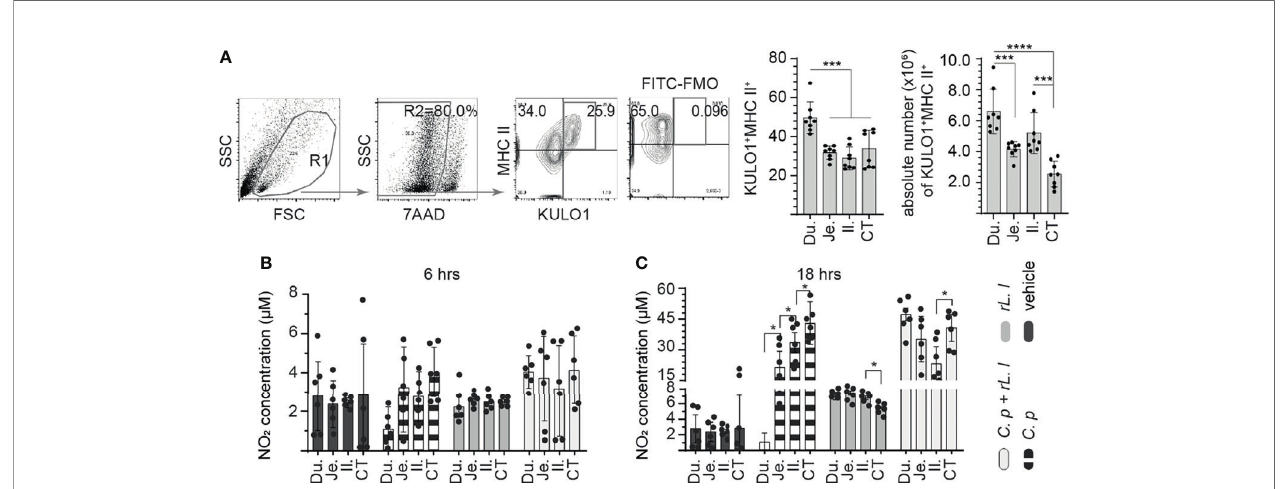
FIGURE 1 | Ex vivo induction of NO production by C perfringens treatment of intestinal monocyte/macrophages. The frequency of small intestine mononuclear cells isolated from 3-week-old layer chickens ( n = 8) were analyzed using fl ow cytometry. (A) Dot plots demonstrating the gating strategy utilized to de fi ne the frequency and absolute numbers of monocyte/macrophages (KULO1+MHC II+) within the duodenum, jejunum, ileum, and cecal tonsils. The respective small intestine mononuclear cells were stimulated with medium alone (vehicle), LPS (1 m g/ml), C perfringens (1 MOI), L. lactis (MOI = 1), and combination of C perfringens (MOI = 1) and L. lactis (MOI = 1). Supernatants were collected at (B) 6 and (C) 18 h poststimulation and NO concentration were quanti fi ed. Paired t -test was used to assess normal distribution and test signi fi cance. * p < 0.05, *** p < 0.0005 and **** p < 0.0001 indicates a statistically signi fi cant difference. The mean ± SD value are shown from three independent experiments performed in triplicates. Du, duodenum; Je, jejunum; Il, ileum; CT, cecal